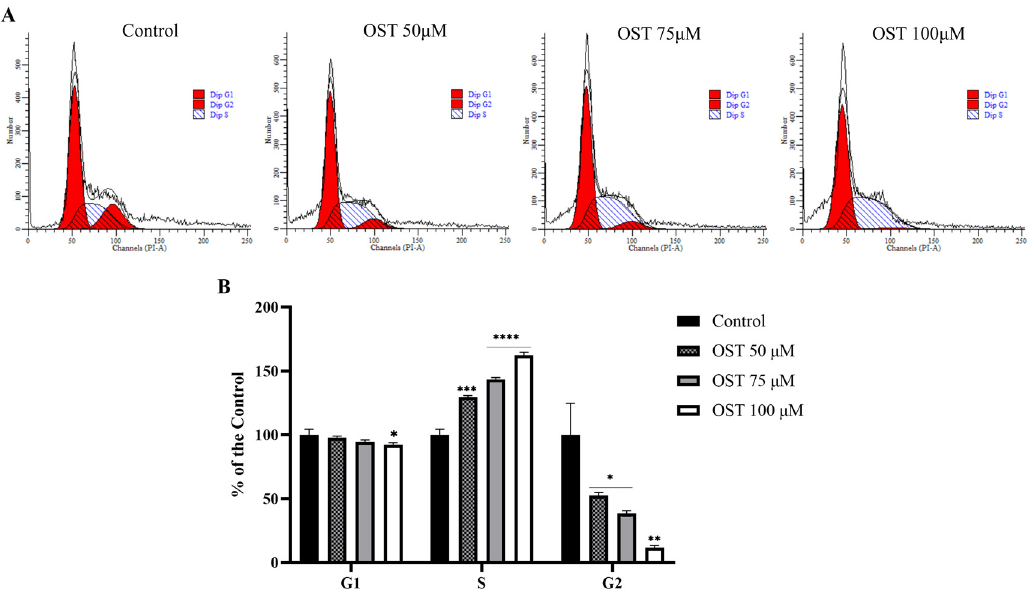
Figure 3. Effect of osthole (OST) on 4T1 cell cycle distribution. ( A ) 4T1 cells were treated with (0, 50, 75, and 100 μ M) OST for 24 h. DNA content was analyzed using flow cytometry with propidium iodide (PI) staining. ( B ) DNA content in each phase of the cell cycle (G1, S, G2) after OST treatment. Compared to that in the control group, Mean ± SD, N = 3, * p < 0.05, ** p < 0.01, *** p < 0.001, **** p < 0.0001.